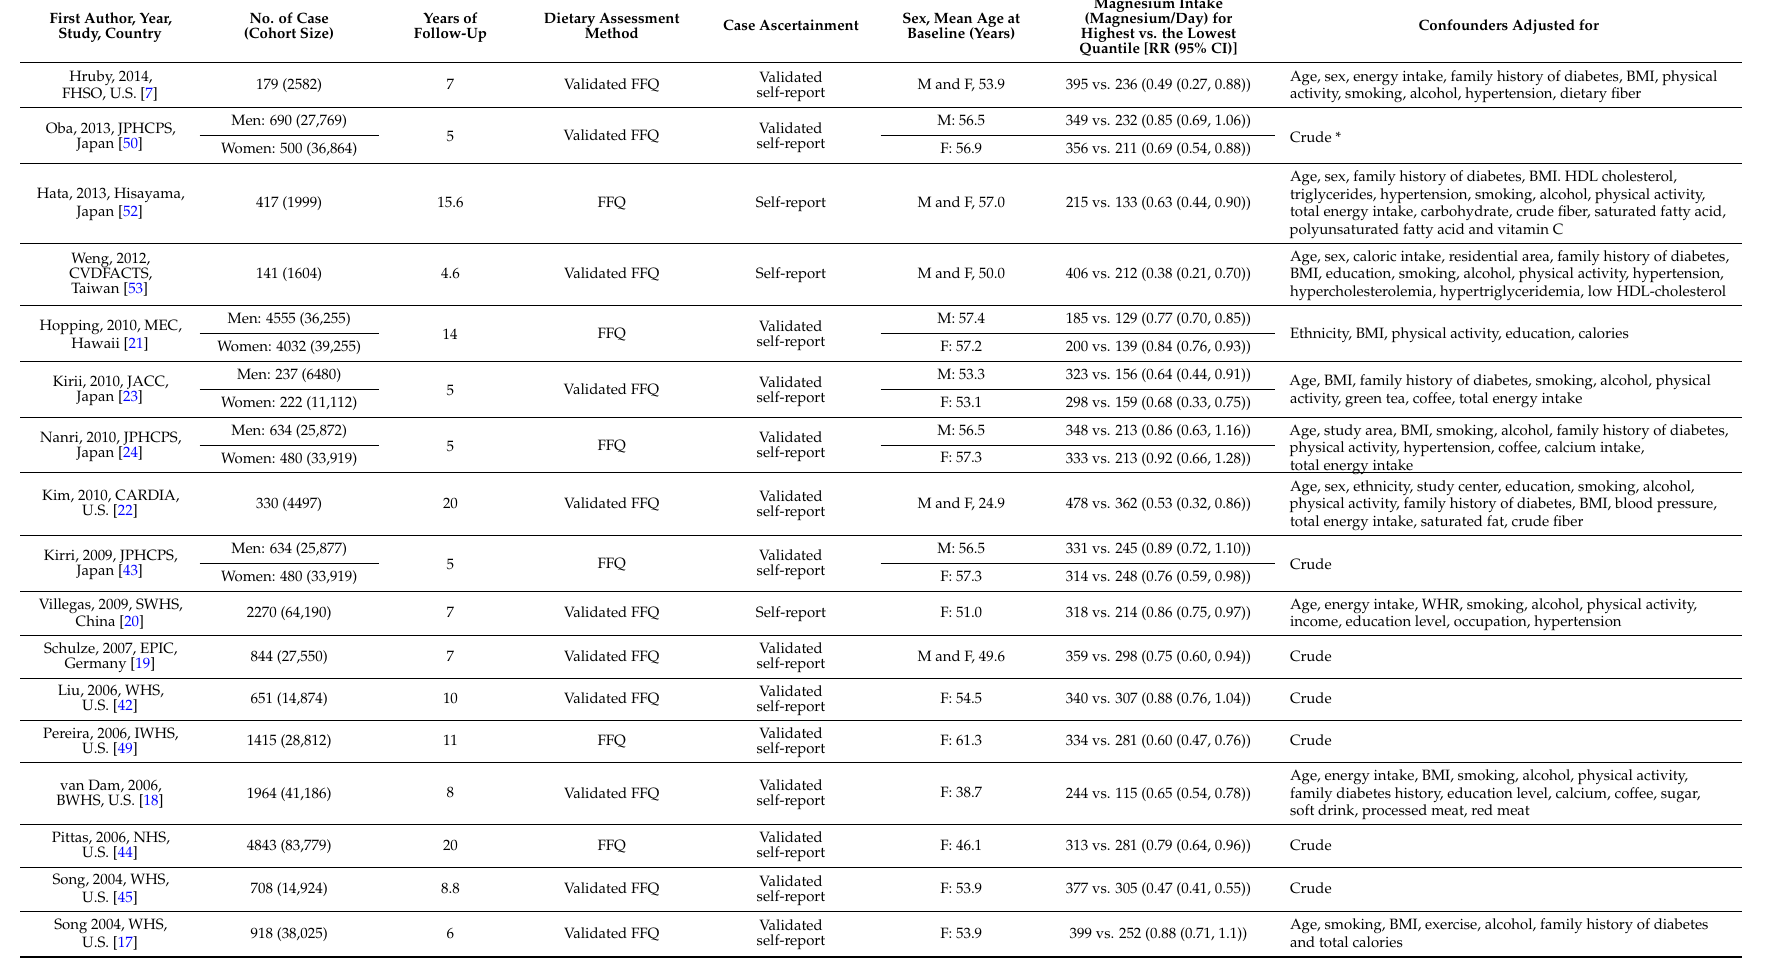
Table 1. Characteristics of 25 cohort studies providing risk estimates for dietary magnesium intake and T2D